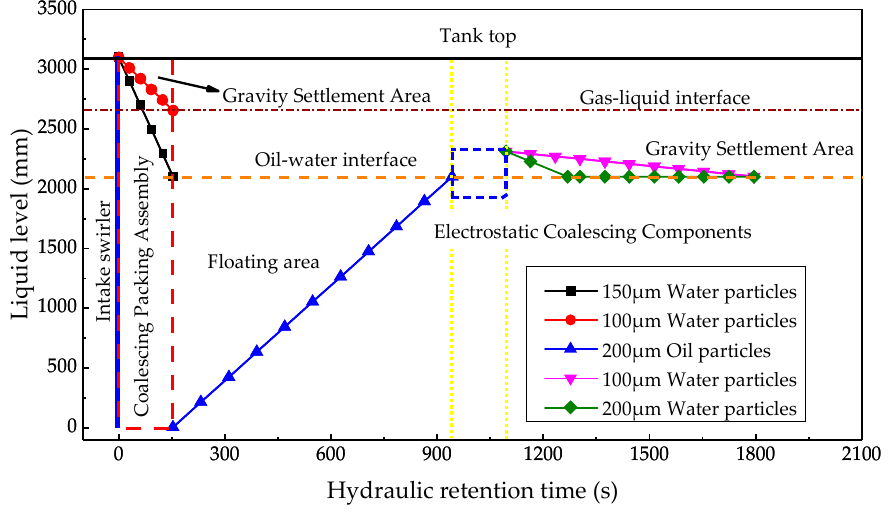
Figure 7. Droplet settling and floating curve inside the electric field-enhanced three-phase separator tank.